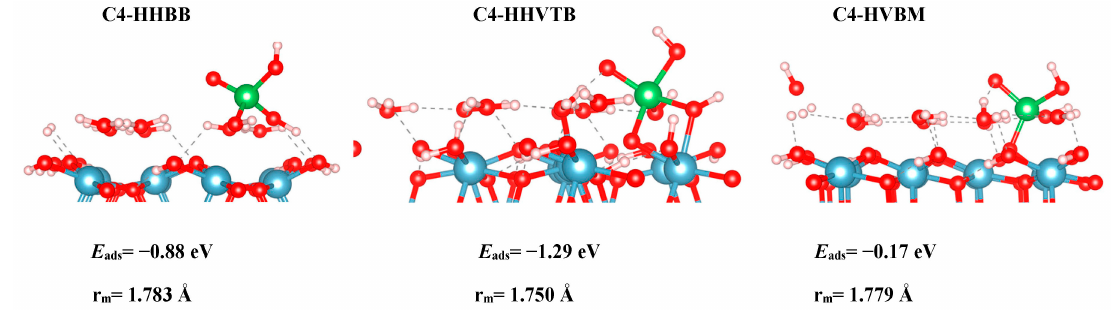
Figure 3. The C3 optimized structures. From left to right: HHBB, HVBM (HHBB), and hill–hill bidentate binuclear structure with a proton rearrangement (HHBB-H). Aluminum, oxygen, hydrogen, and arsenic are represented by the colors blue, red, white, and green respectively. E ads and r m are the adsorption energies and averaged As–O surf distances, respectively.